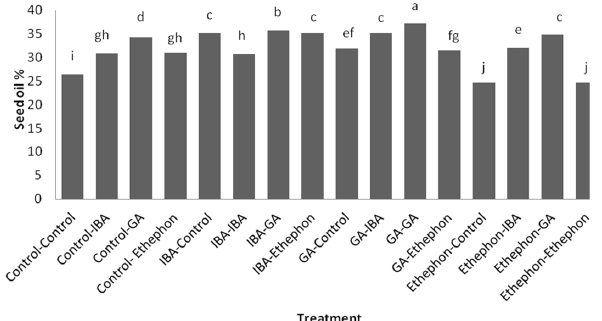
Fig. 5. Effect of PGRs on oil % of medicinal pumpkin ( Cucur- bita pepo var . styriaca cv. ‘Kaki’) in trellis method